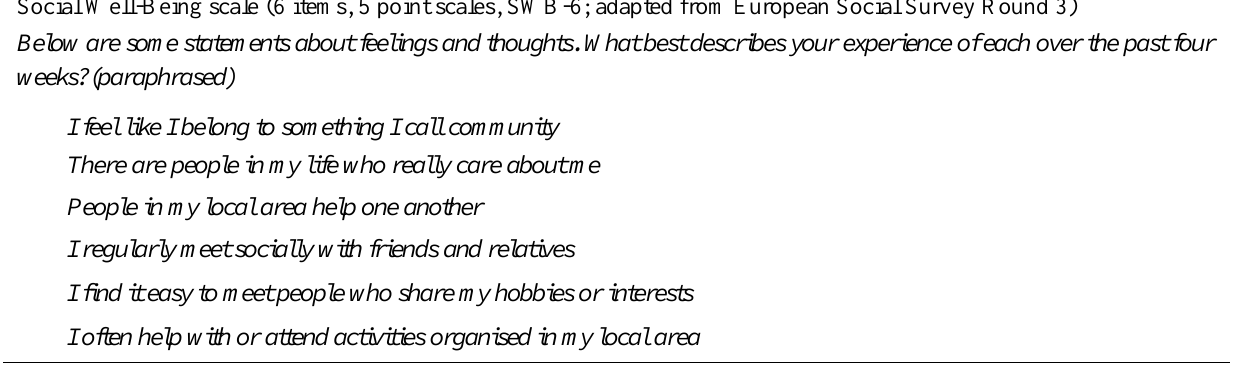
Table 1. Summary of the measures covered in the